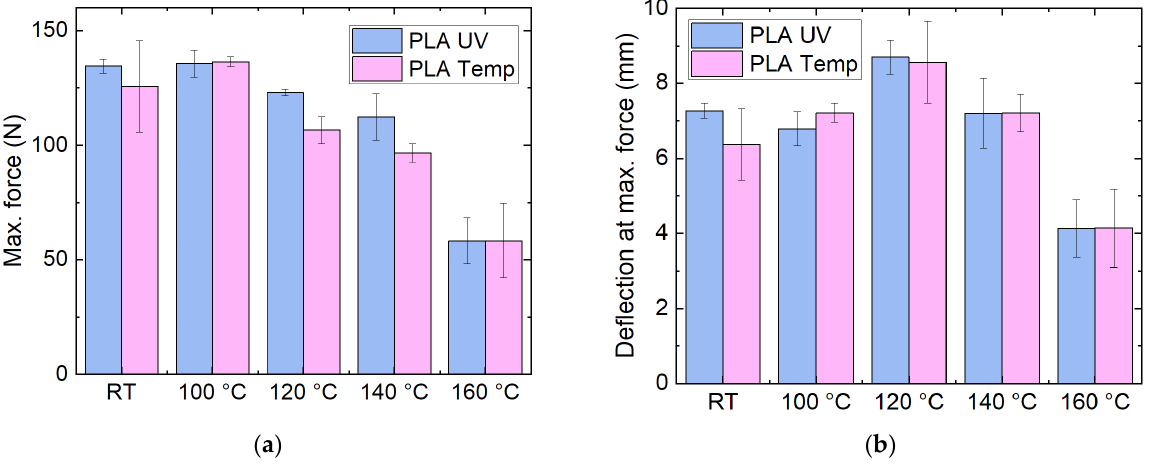
Figure 9. Mechanical properties of filled PLA samples, as printed (RT) and heat-treated at different temperatures: ( a ) maximum force; ( b ) deflection at maximum force in 3-point bending